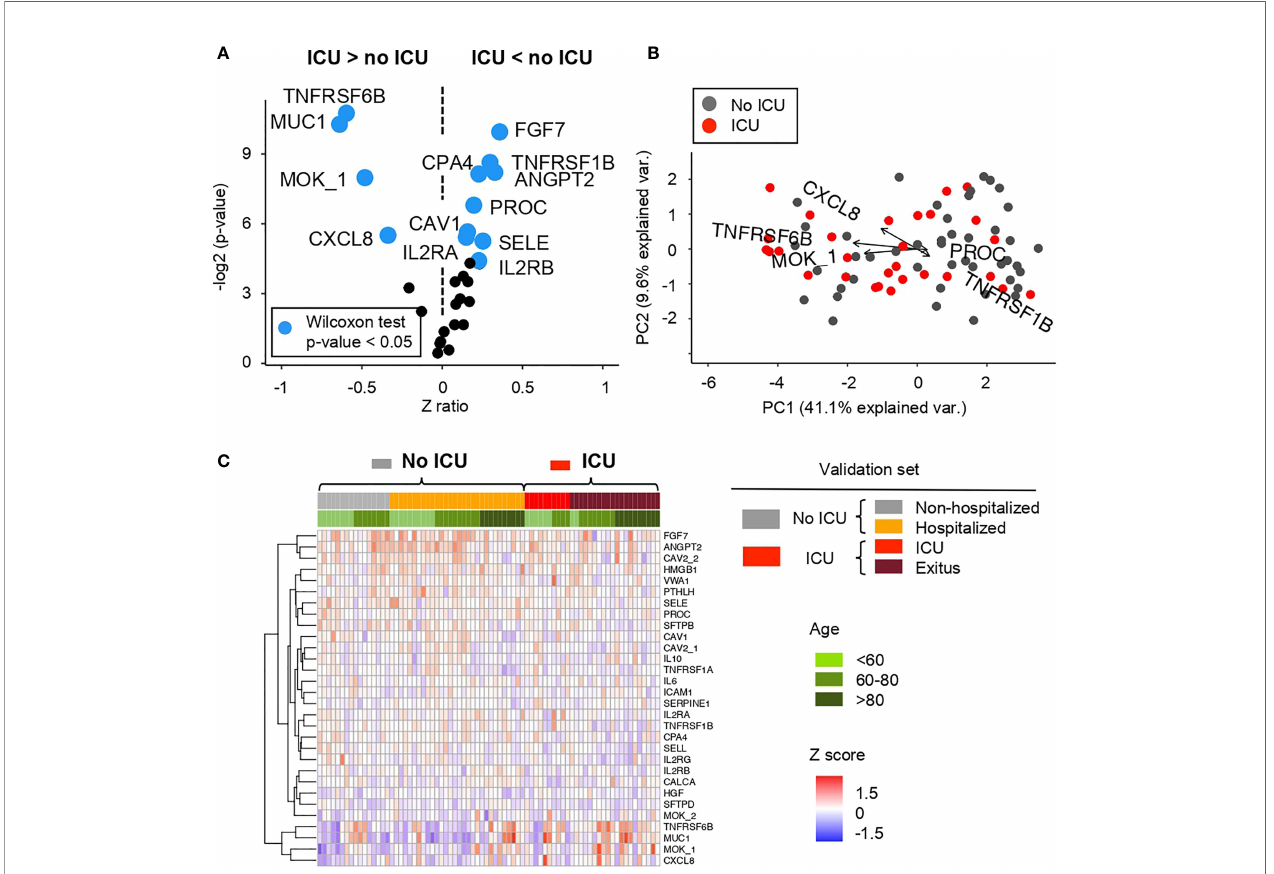
FIGURE 5 | Comparative analysis of the Z scores between patients showing mild and severe ARDS symptoms in the cohort 2 obtained from the microarray for AABs (A) Volcano plot summarizing the statistical signi fi cance of Z score ratios between patients with mild symptoms or hospitalized (no ICU) and patients admitted to the ICU and/or deceased in the cohort 2 (X-axis). The difference between means was evaluated applying Wilcoxon Rank Sum test (Y-axis). AABs showing statistically signi fi cant mean differences are highlighted in blue and larger dots. (B) Canonical biplot representing the PCA of the microarray for AABs employed in the cohort 2. Dots represent samples and vectors the AAB variable contribution to the fi rst two principal components at X and Y-axes. The biplot only highlights the most exemplary AAB variables. (C) Heat map describing Z score values obtained from the microarray for AABs in the cohort 2. Samples are ordered according to clinical symptoms and patient age (green color scale). Samples grouped under No ICU category include patients with mild symptoms or hospitalized -columns labeled in gray or orange color in the heat map and summarized in gray in the biplot-. UCI group include patients admitted to the ICU and/or deceased -columns labeled in red or brown color in the heat map and summarized in red in the